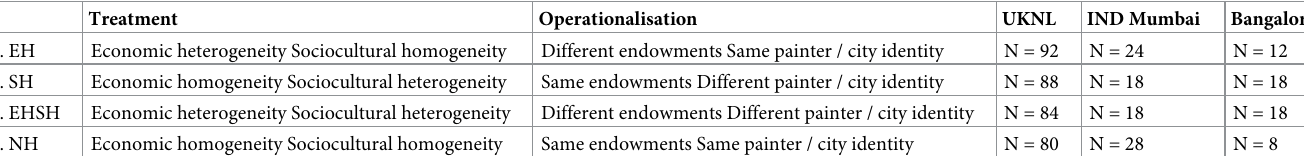
Table 1. Overview of